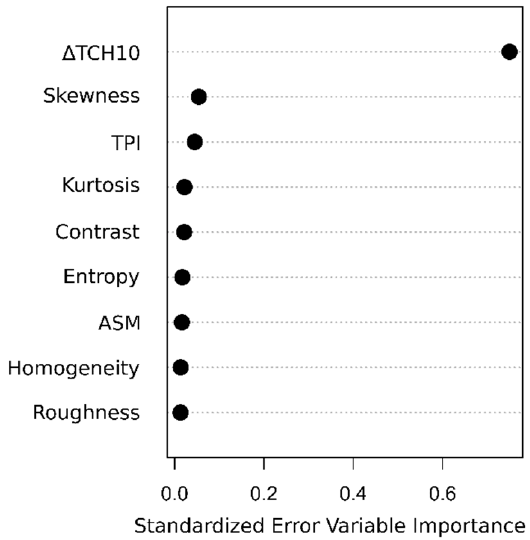
Figure A3. The nine predictor variables, contributing to the random forest predictions in the dir+tex approach, ranked by decreasing standardized importance. Canopy height change ( Δ TCH10) was the most important predictor, followed by eight canopy texture metrics. For explanation of the abbreviations, please refer to Section 2.5.